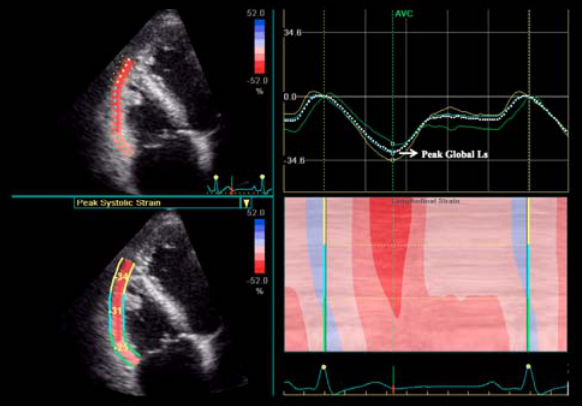
Figure 1. Right ventricular longitudinal strain by two-dimensional speckle tracking in a healthy subject. Upper right: longitudinal strain dotted curve showing the main values. Ls = longitudinal strain.